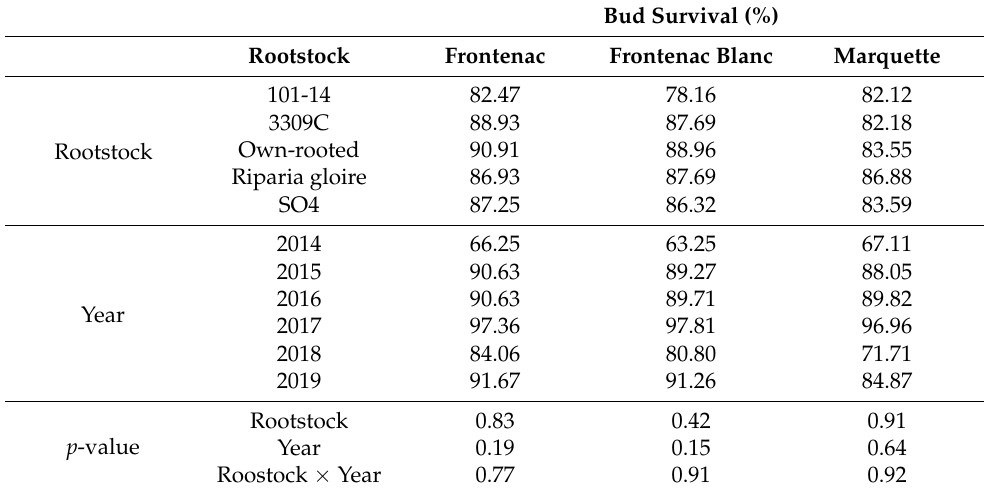
Table 4. Effect of rootstock on bud survival of the three cold hardy hybrids.